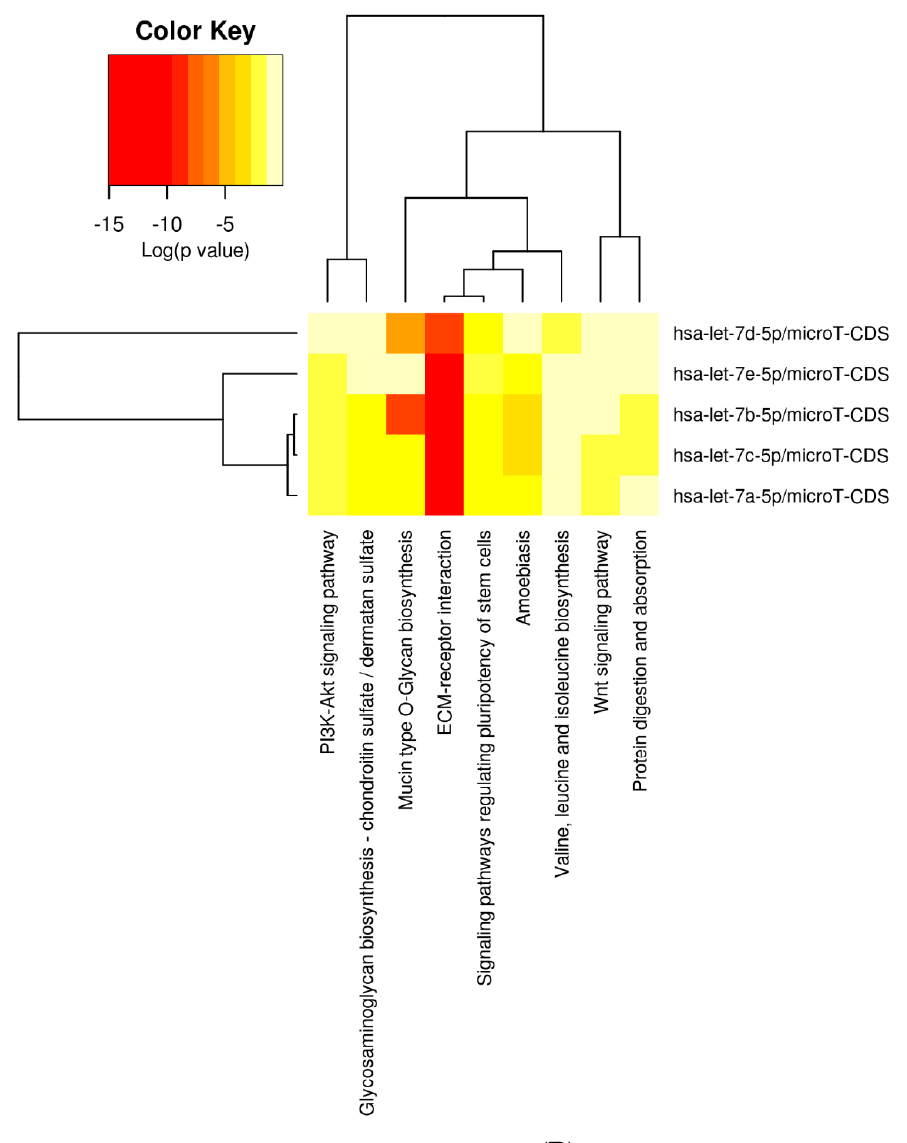
Figure 1. ( A ) Hierarchical clustering analysis utilizing the 20 samples of the screening cohort with the 20 miRNA detected across all samples and differentially expressed ( p < 0.05 and FDR < 0.25) between pT1 and pT3 tumors (all ≤ 5 cm). ( B ) Relative expression level of let ‐ 7c ‐ 5p in these specimens. ( C ) ROC curve for let ‐ 7c ‐ 5p discriminating these pT1 and pT3 cohorts. ( D ) Two ‐ way hierarchical clustering of the significant KEGG pathways, resulting from the analysis of the differentially expressed let ‐ 7 miRNAs in this study.